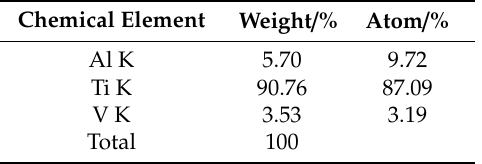
Table 1. The chemical compositions and their contents in the powder.